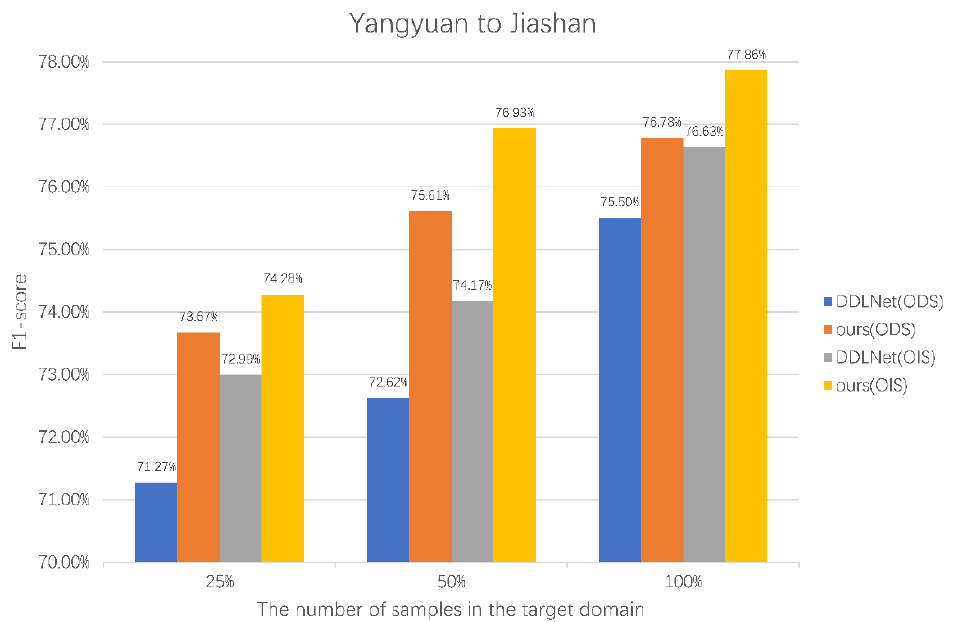
Figure 6. Comparison of experimental results between SEGOS and our method using different numbers of samples in Jiashan County.